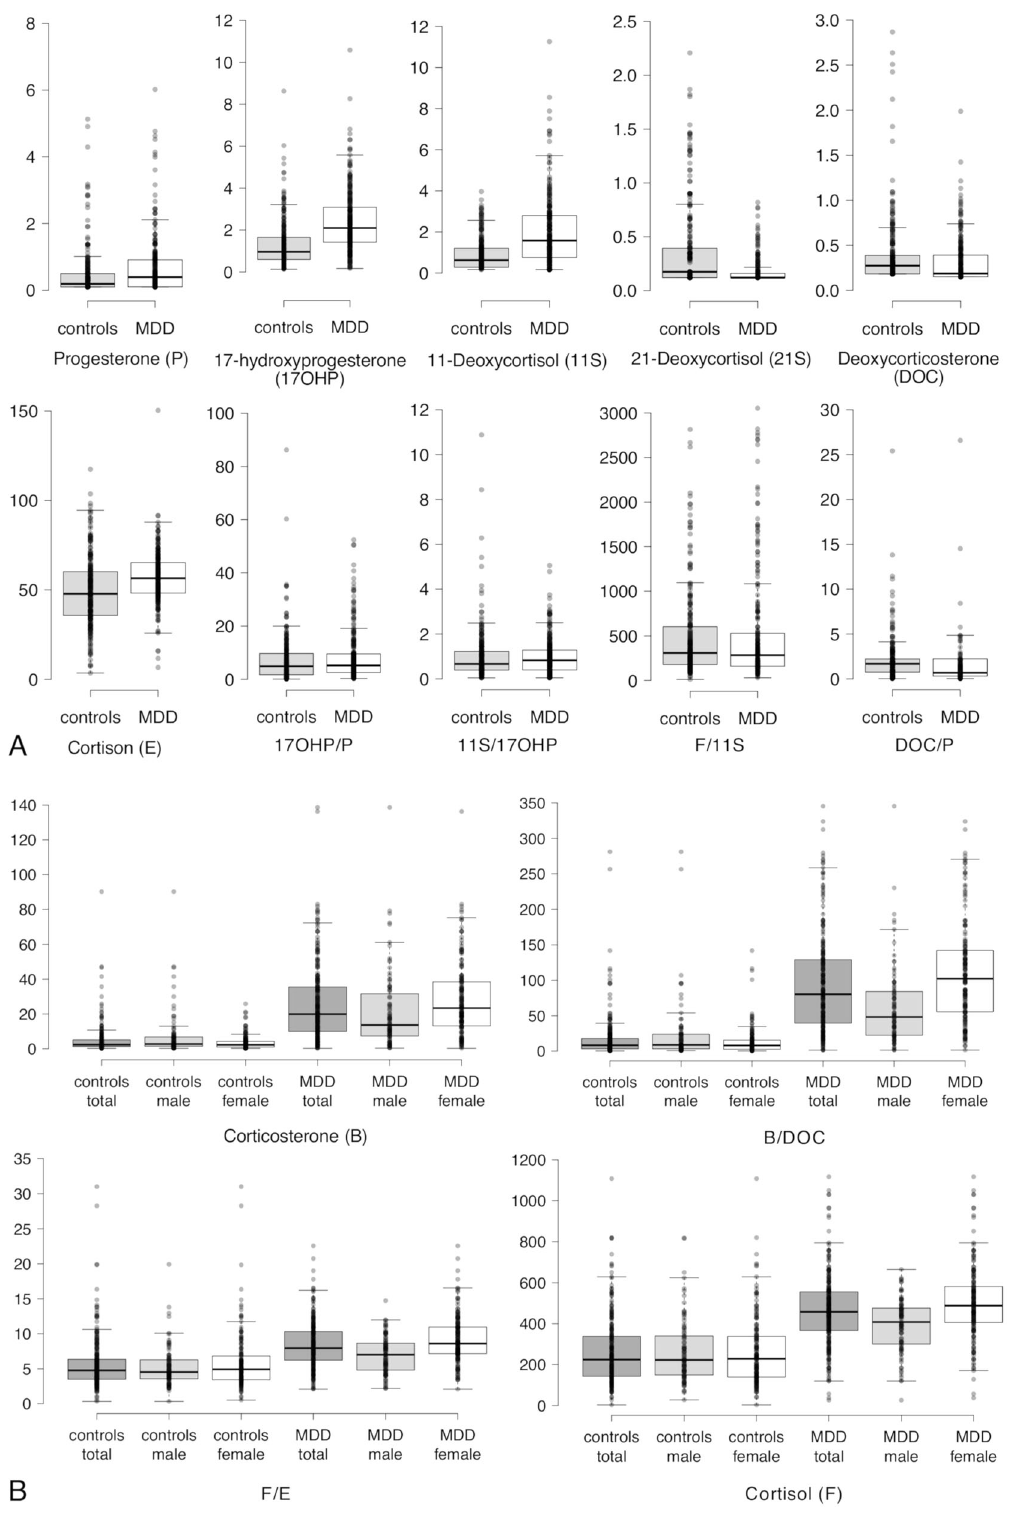
Fig. 2 Boxplots for all steroids and steroid ratios. Panel ( A ) displays steroids and steroid ratios with, panel ( B ) without a signi fi cant interaction with sex, separately for the reference cohort and adolescents with MDD ( x axis). The y axis corresponds to nmol/l concerning single steroids and is unit-free concerning steroid ratios. Note, extreme outliers (exceeding three times the interquartile range) are not displayed for values of B and the ratios of cortisol/11-deoxycortisol, deoxycorticosterone/progesterone, and corticosterone/deoxycorticosterone to avoid a distortion of the y axis and the graphical representation in the lower range of values. The full range of values, including extreme outliers, is shown in Supplementary Fig